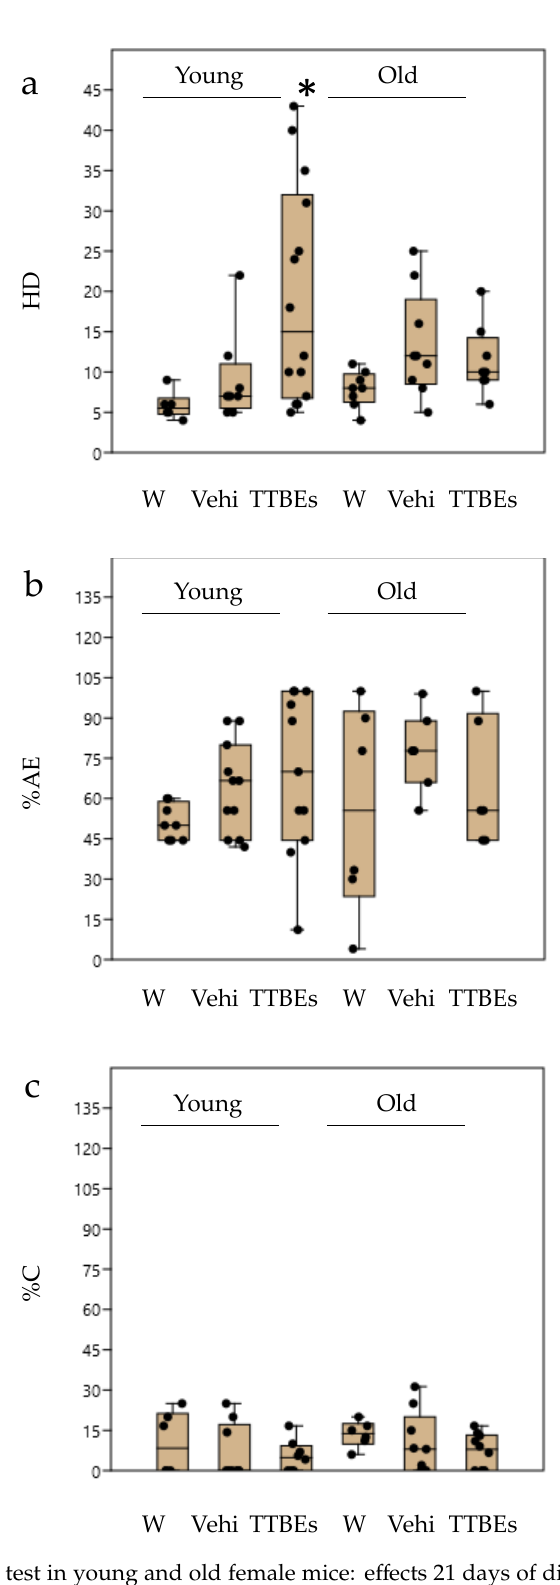
Figure 7. Hole Board test in young and old female mice: e ff ects 21 days of dietary integration with vehicle, TTBEs respect to water. Behavioral skills were quantified as ( a ) n ◦ head dippings (%HD), ( b ) % of area explored (%AE), ( c ) % of entries into center (%C). Data represent the mean ± S.E.M. ( n = 6 (W), 11 (Vehi) 14 (TTTBEs) young and ( n = 8 (W), 9 (Vehi) 9 (TTTBEs) old mice analyzed in three di ff erent trials. Statistical analysis was performed by applying ANOVA followed by the Tukey’s multiple comparison test. * p < 0.05